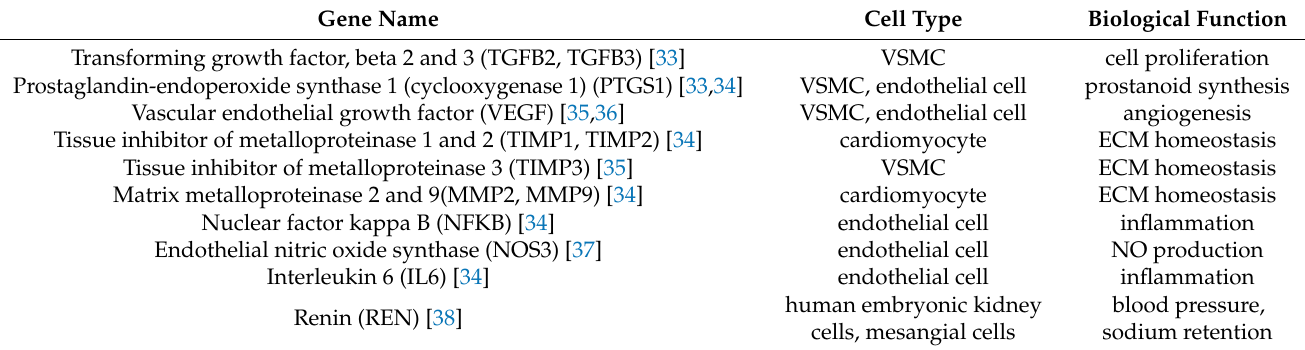
Table 1. Selected VitD-regulated genes linked to cardiovascular and cerebrovascular